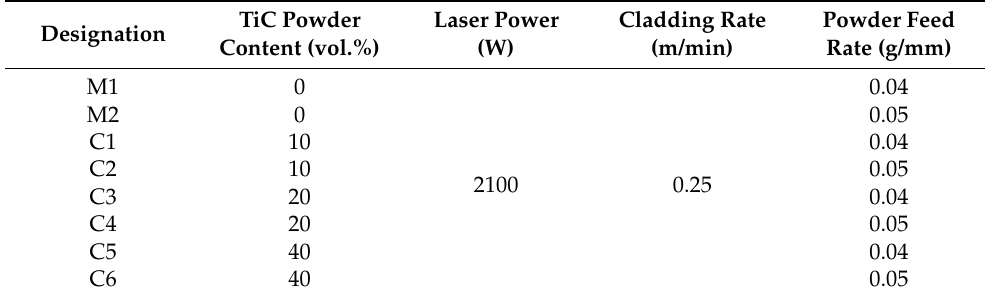
Table 3. Laser-cladding process